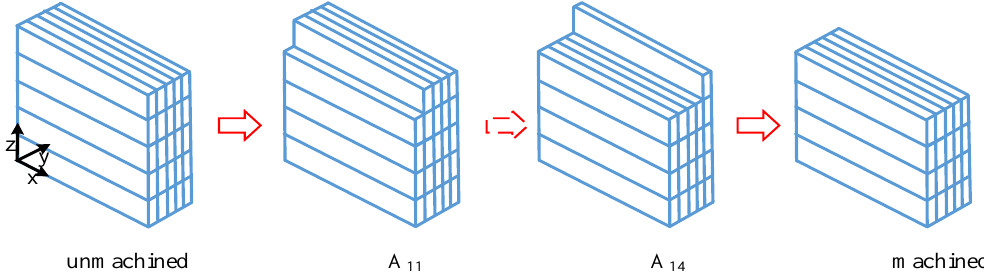
Figure 4. Schematic diagram of machining process.